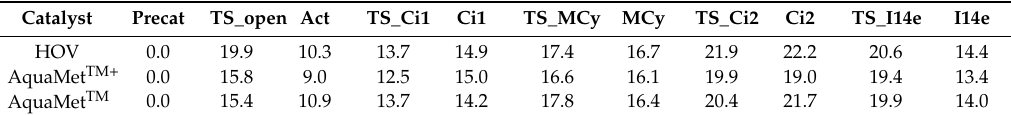
Table 1. Relative energies of the reaction profile of the initiation in olefin metathesis with ethylene as a substrate for the Hoveyda catalysts (HOV), with the tagged N-heterocyclic carbene (NHC) ligand, including the chloride counteranion (AquaMet TM ) or not (AquaMet TM + ). Energy values in kcal / mol.